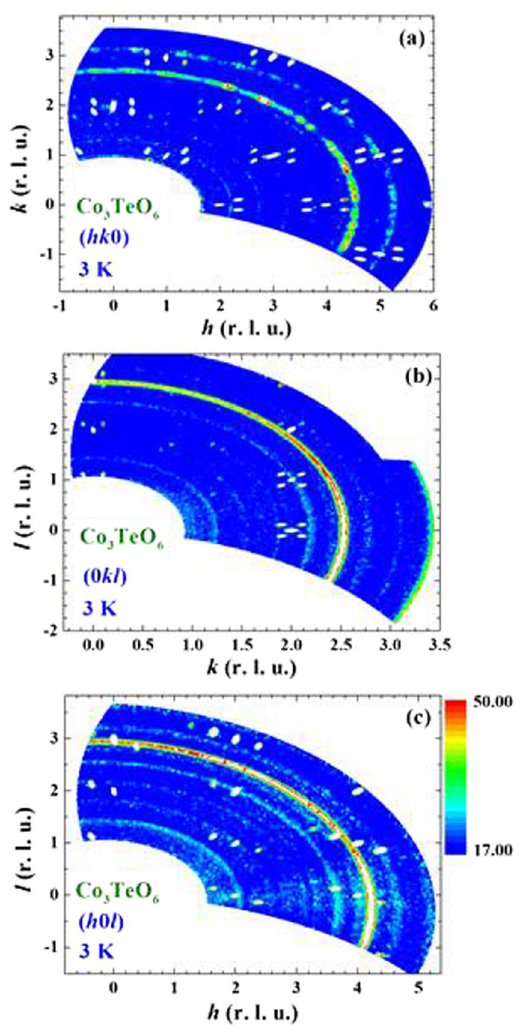
Figure 5. Neutron-diffraction intensity maps observed in the ( a ) ( hk0 ), ( b ) ( 0kl ) and ( c ) ( h0l ) scattering planes, obtained at 3 K, using unpolarized neutrons. Four satellite magnetic reflections associated with each commensurate Bragg position are revealed in the ( hk0 ) and ( 0kl ) scattering planes; while two satellite magnetic reflections are revealed for each reflection in the ( h0l ) scattering plane. Second-order satellite magnetic reflections associated with the reflections at the (203), (400) and (401) Bragg positions are